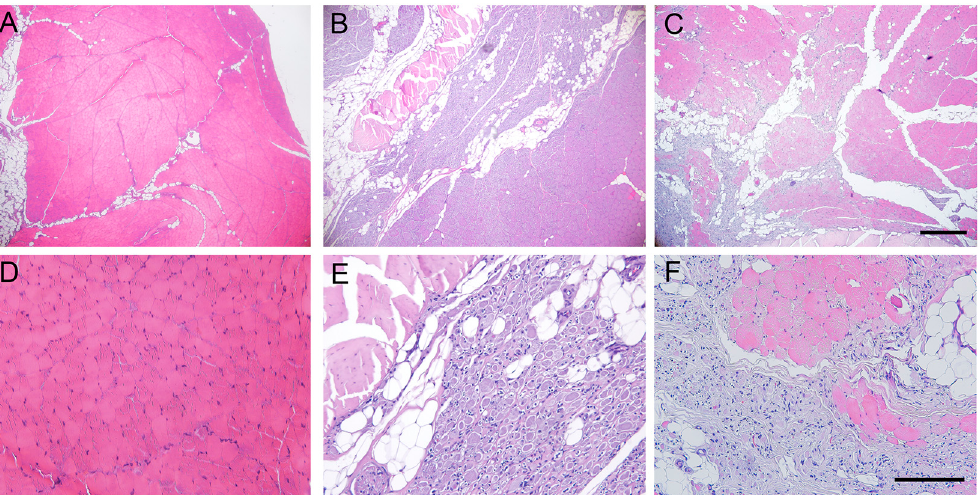
Figure 6. Representative micrographs of cross-sections of the tibialis anterior muscle stained with hematoxylin and eosin from ( A , D ) a control muscle, ( B , E ) a sheep of group AG5, ( C , F ) a sheep of group AG7, taken at ×40 magnification ( A – C ), scale bar 200 μ m, and at ×200 magnification ( E – F ), scale bar 100 μ m. Note the areas of hypotrophic muscle fibers with inflammatory cell infiltration in the denervated muscle areas of AG sheep.